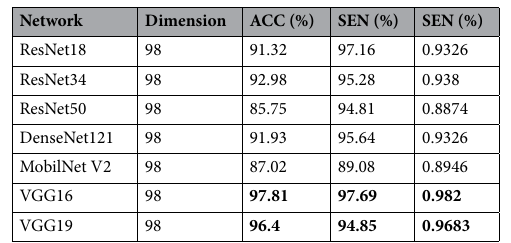
Table 1. Comparative experiment of different architectures. Significant values are in